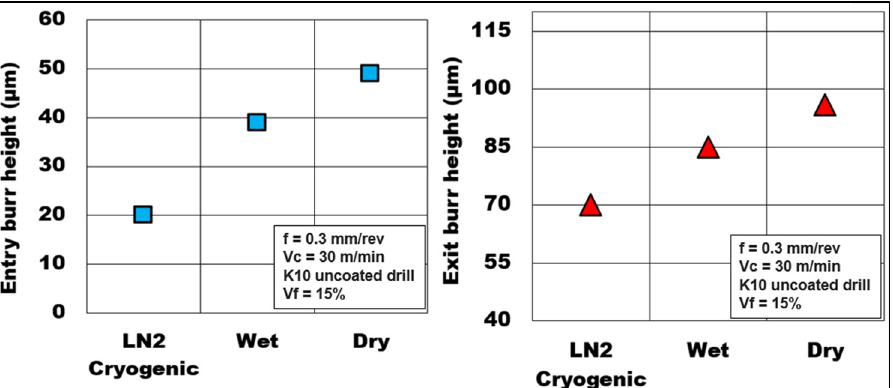
Figure 12. Effect of coolant on burr height during machining Mg-9Al-1.4Zn-based hollow alumina syntactic foams.